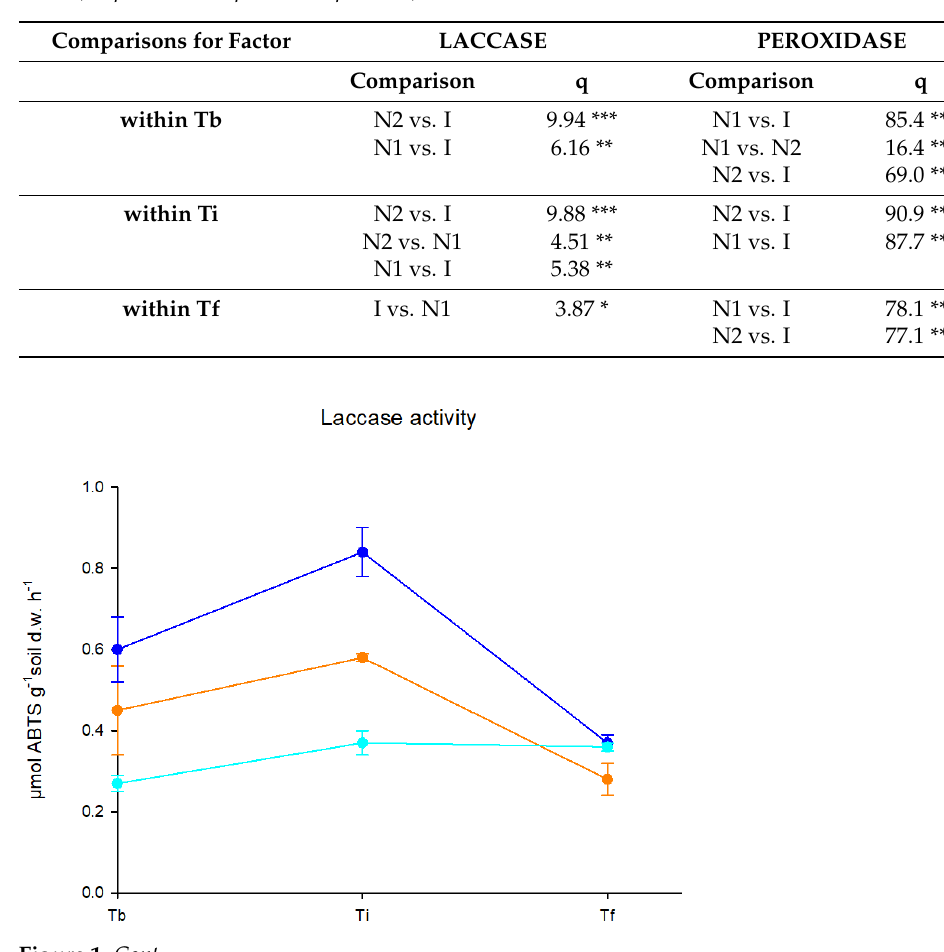
Figure 1. Temporal dynamics of laccase and peroxidase activities in natural (N1: yellow line, N2: blue line) and industrial (I: light blue line) soils during incubation. Vertical bars represent standard errors of the means ( n = 3). Table 2. Microbial groups in each soil system (N1, N2, I) at each sampling time (T b , T i , T f ), expressed as mean values ± standard errors in respect to the total microbial biomass (mol%). Time Soil